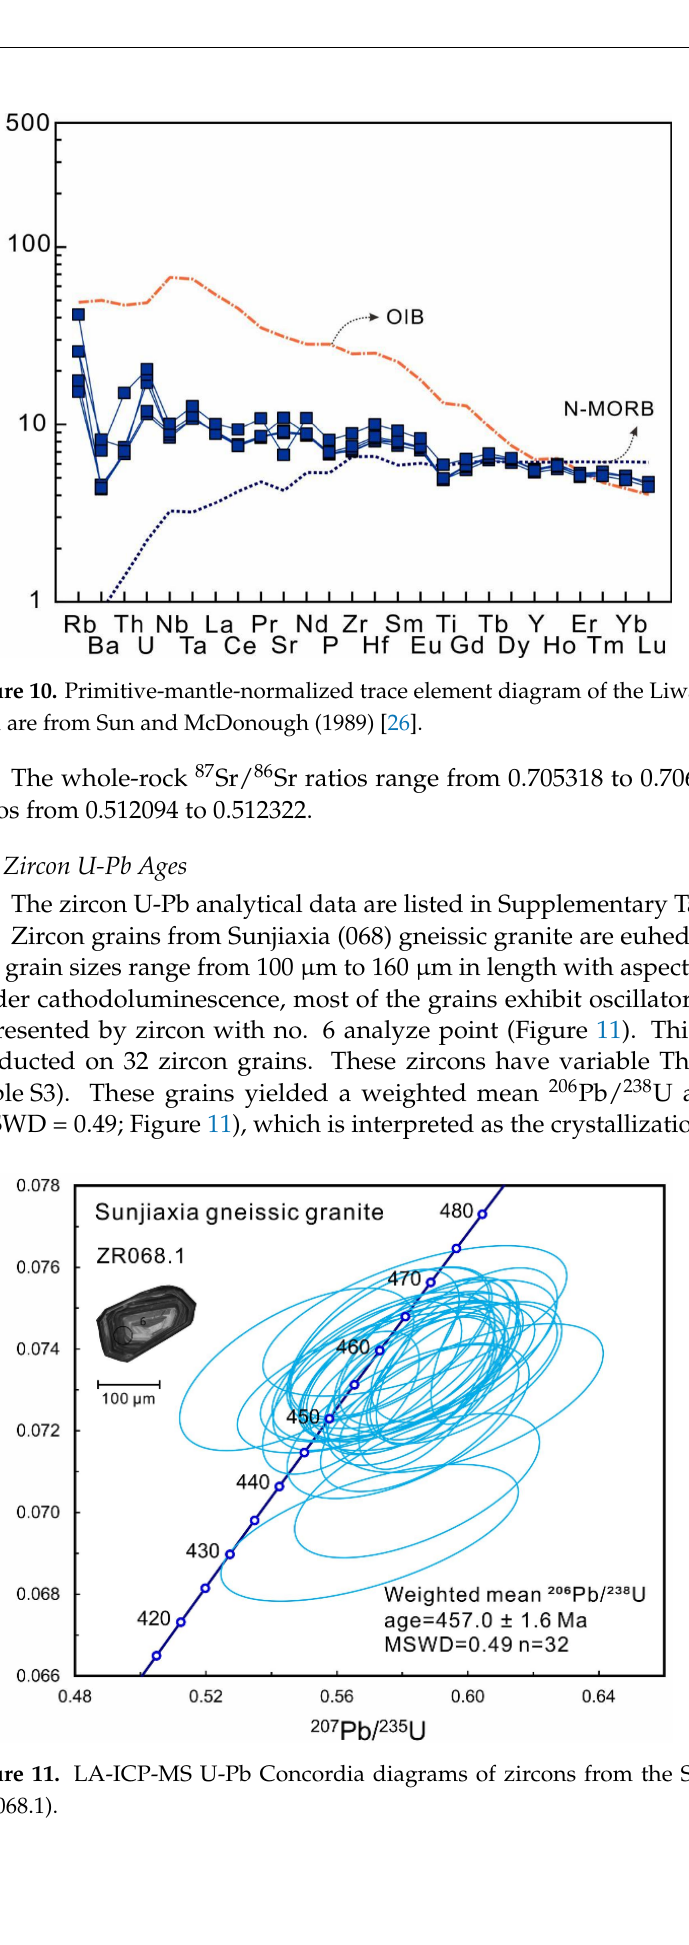
Figure 11. LA-ICP-MS U-Pb Concordia diagrams of zircons from the Sunjiaxia gneissic granite (ZR068.1).